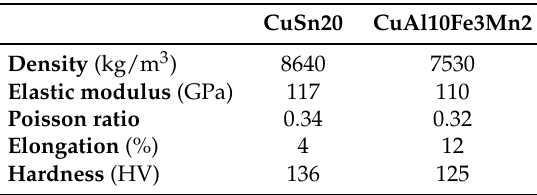
Table 1. Mechanical properties of the alloys used.